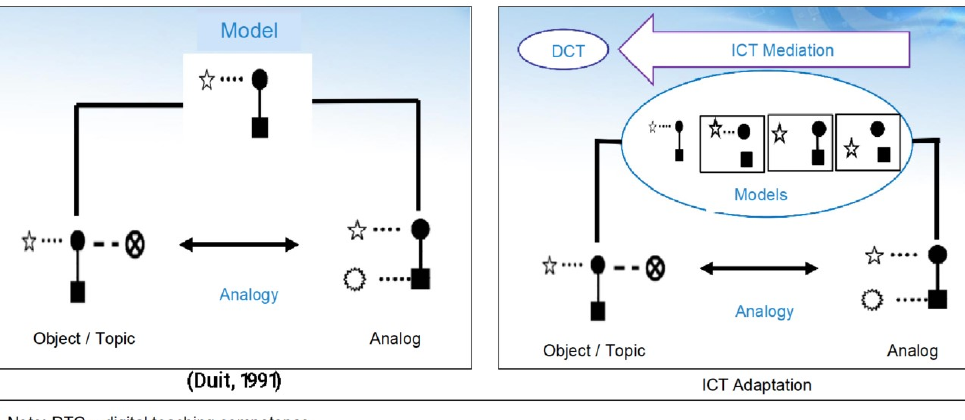
Figure 1. Adaptation of Duit (1991) to an ICT-mediated approach